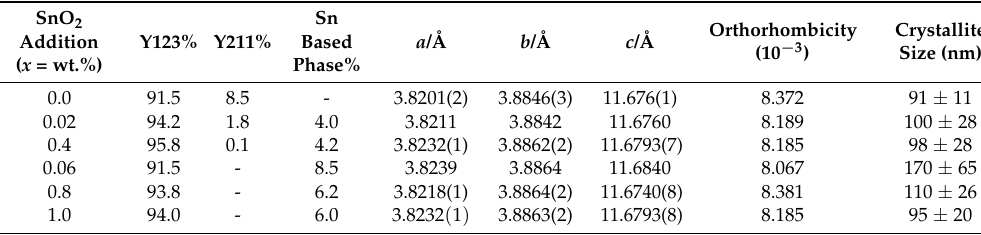
Table 1. Phase percentage of Y-123, Y211 and SnO 2 , including the lattice parameters a , b , and c , orthorhombicity and crystallite size of the Y-123 samples at x = 0.0, 0.2, 0.4, 0.6, 0.8, and 1.0 wt.% SnO 2 addition.